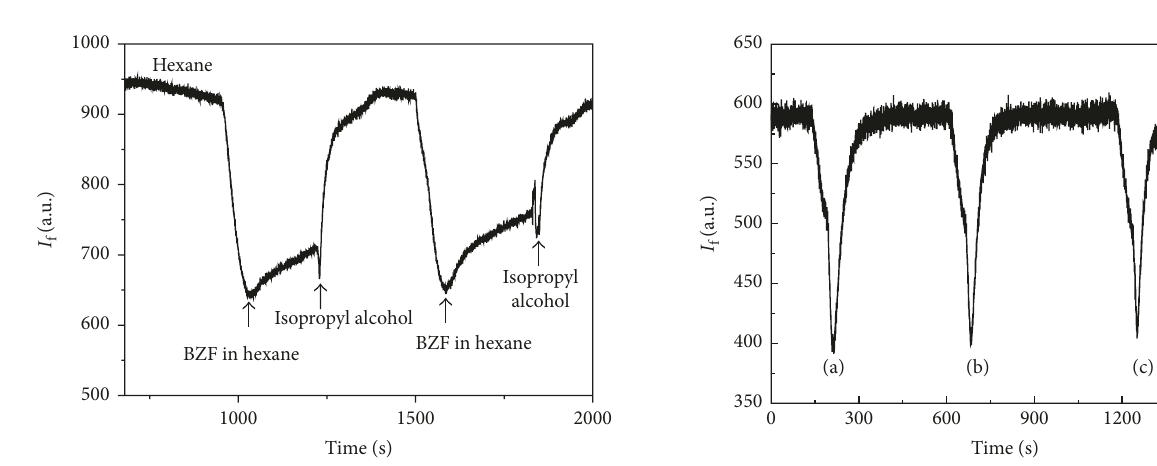
Figure 11: MIP response profile for BZF with different hex- ane/isopropyl alcohol mixtures as a carrier: (a) 90:10 (v/v), (b) 70: 30 (v/v), and (c) 30 :70